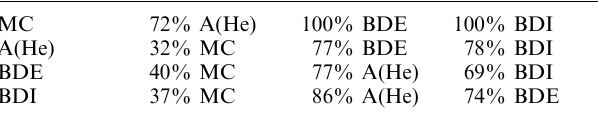
Table 2. Association between IP signatures